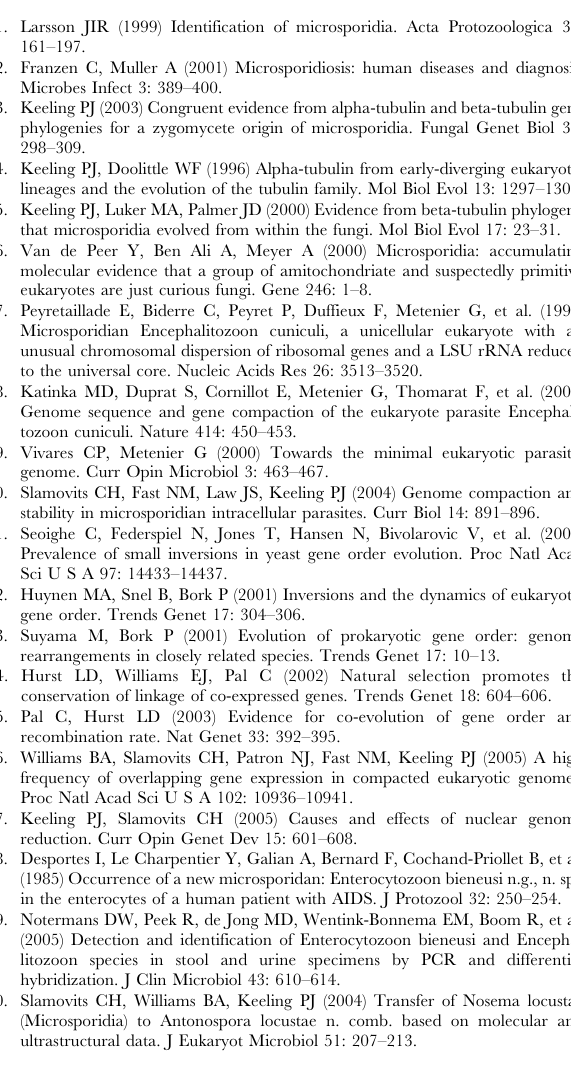
Figure S2 Genomic sequence of the of the scaffolds used in this study.